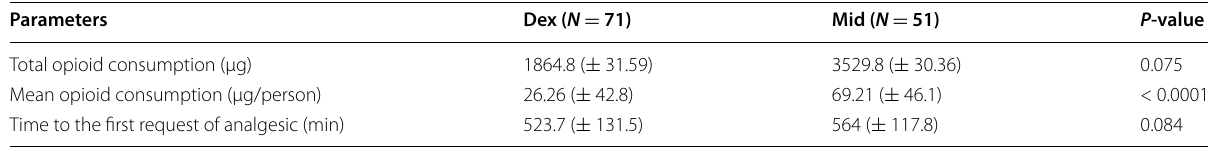
Table 4 Opioid consumption and time to the first request of an analgesic in the study population Parameters